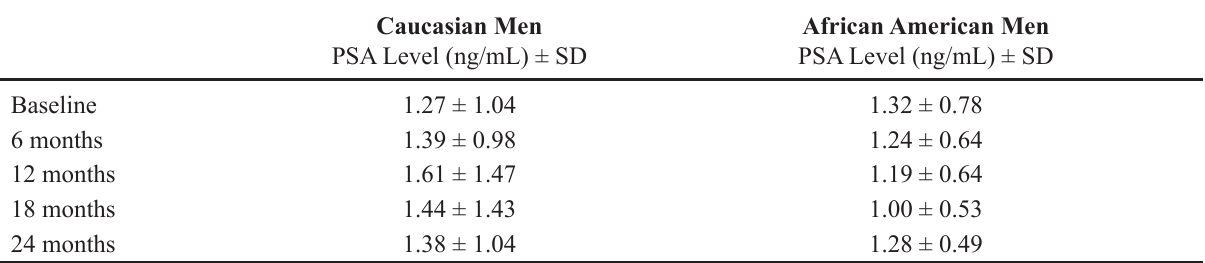
Table 3 – Racial differences in PSA level.